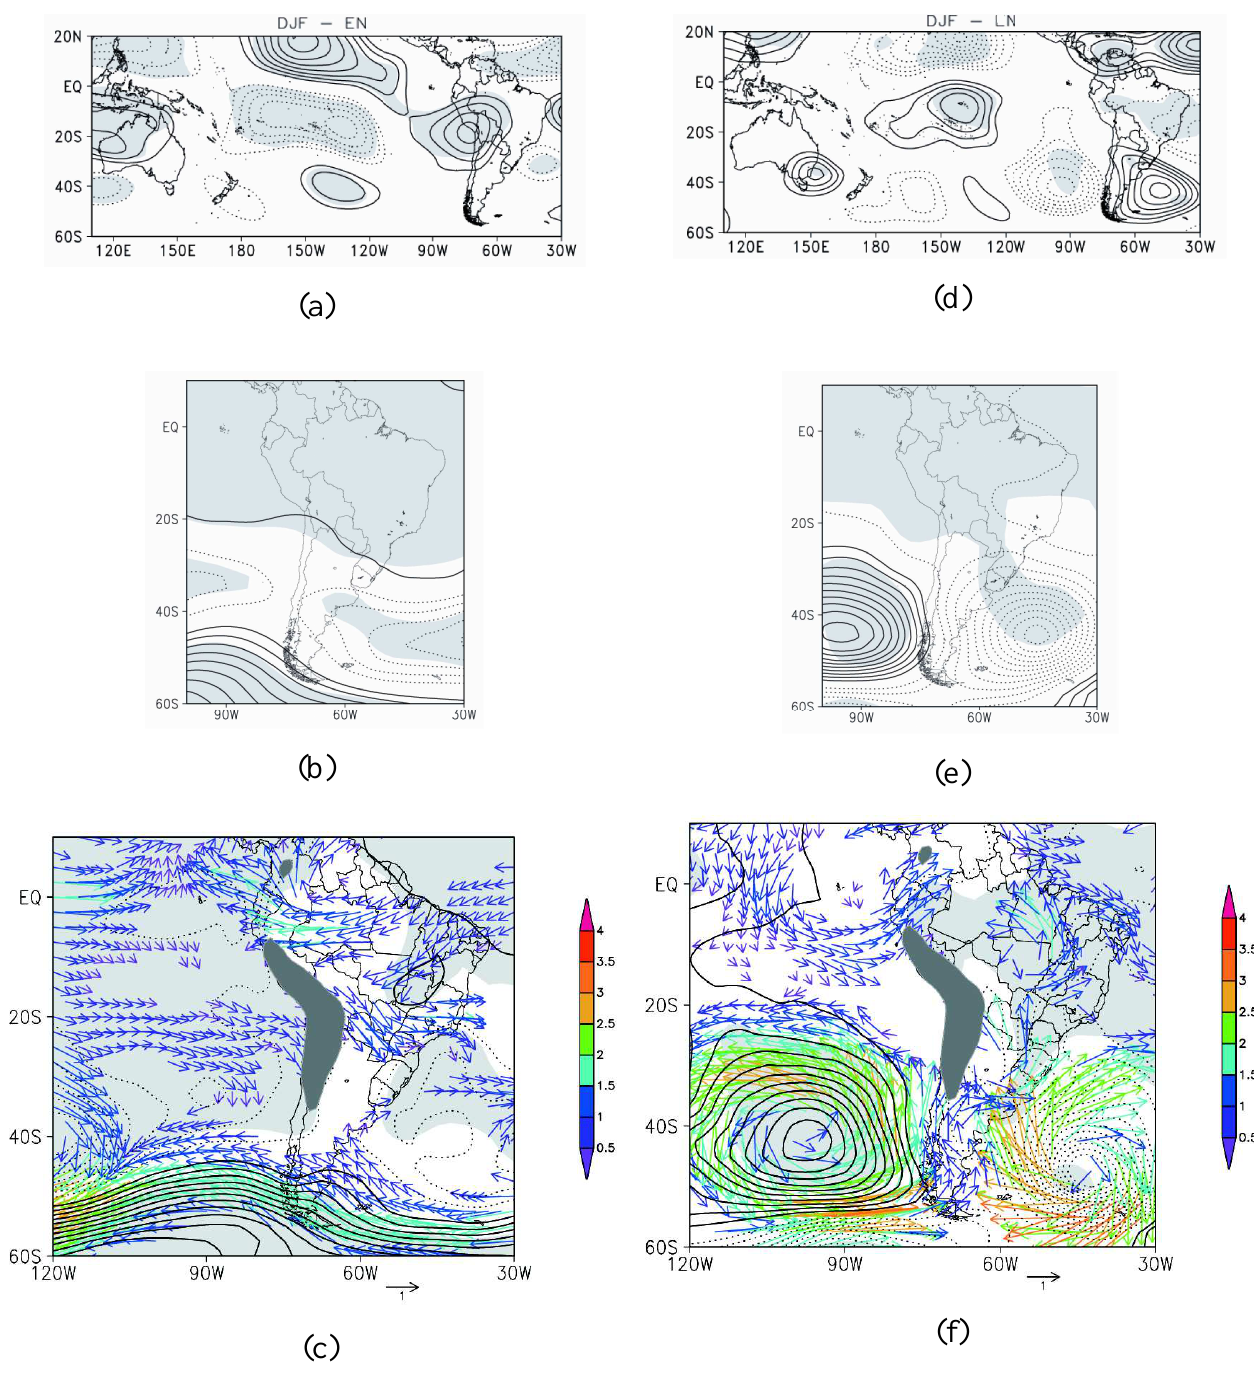
Fig. 1. Anomaly composites during austral summer from 1977–2004. On the left panel (a) 200hPa zonally asymmetric streamfunction; (b) 500hPa geopotential height and (c) 850hPa wind and SLP for EN years; on the right panel the same as left panel but for LN years. Contour interval is 1 × 10 6 m 2 s − 1 , 5m, 1hPa. A reference vector of 1ms − 1 is shown at the lower right-hand side of each panel. Negative contours are dashed and the zero contours are omitted. Areas where anomalies are statistically significant at the 95% level are shaded in gray.